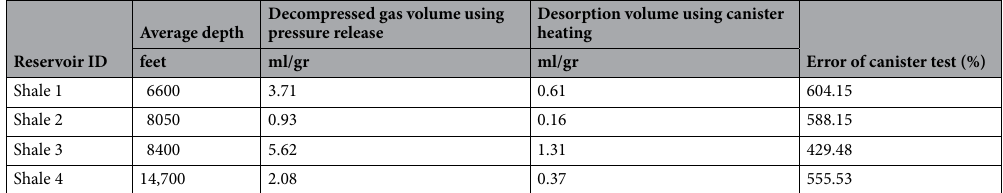
Table 4. Results of gas in place measurements by pressurized side-wall cores and standard canister methods. The side-wall coring was deployed in Marcellus formation.